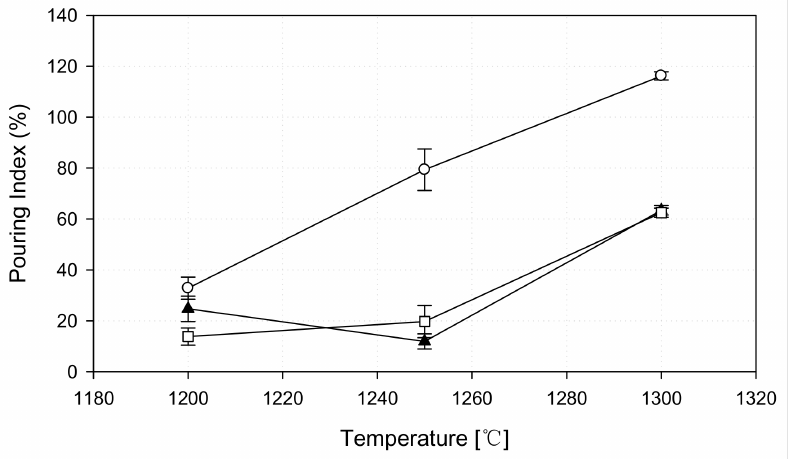
: Sewage sludge, (cid:78) : Sawdust, (cid:35)